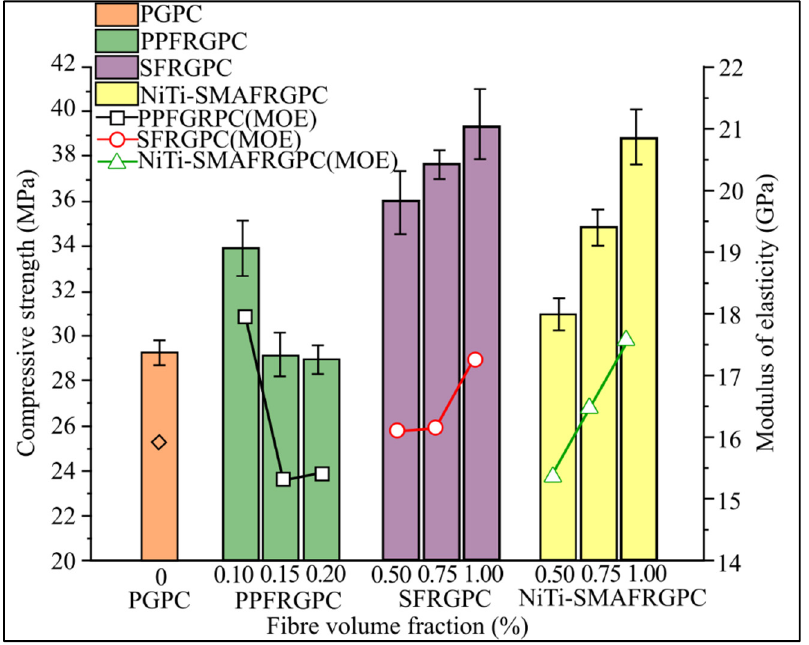
Figure 2. Compressive strength and MOE of PGPC, PPRGPC, SFRGPC, and NiTi SMAFRGPC under different fiber volumes [60].